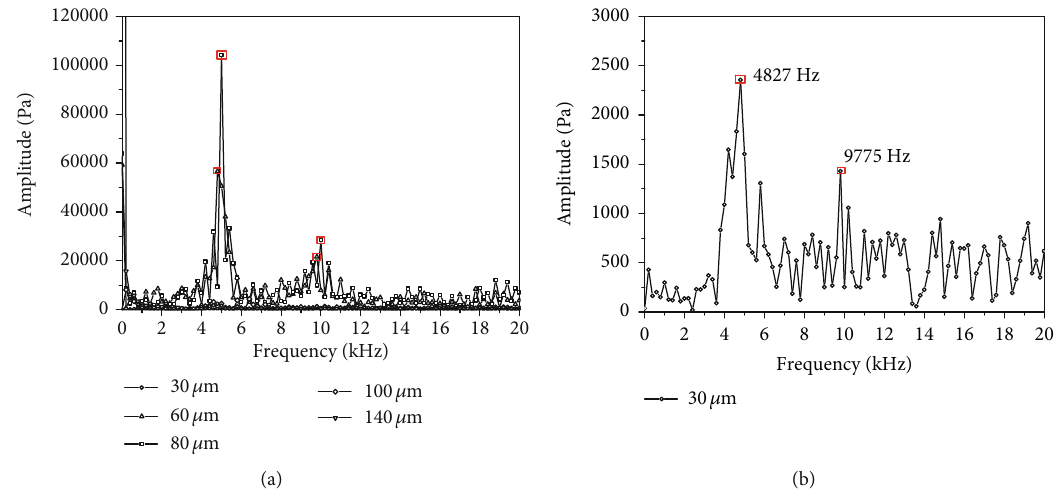
Figure 6: The FFT analysis of pressure oscillations in Case 1-Case 5. (a) FFT analysis in Case 1-Case 5. (b) FFT analysis in Case 1.